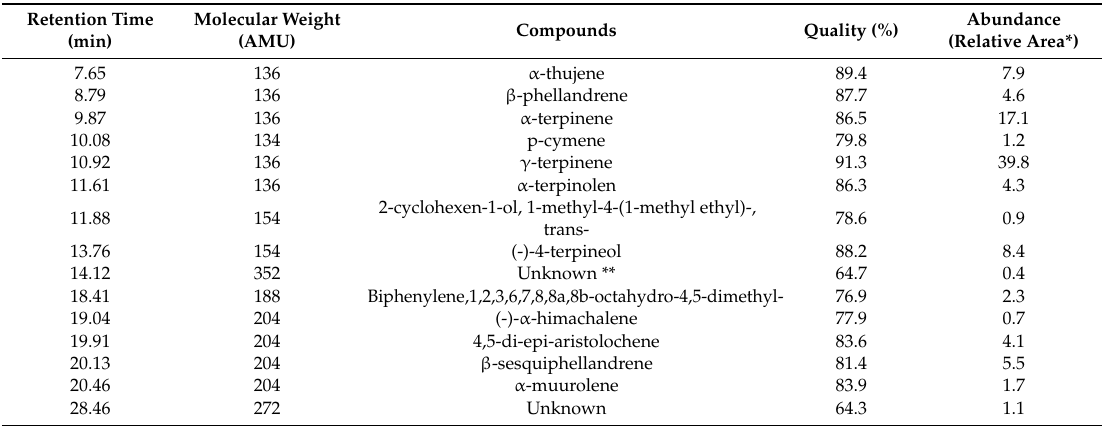
Table 2. The components in VOCs of the endophytic fungus Diaporthe apiculatum strain FPYF 3052. Retention Time